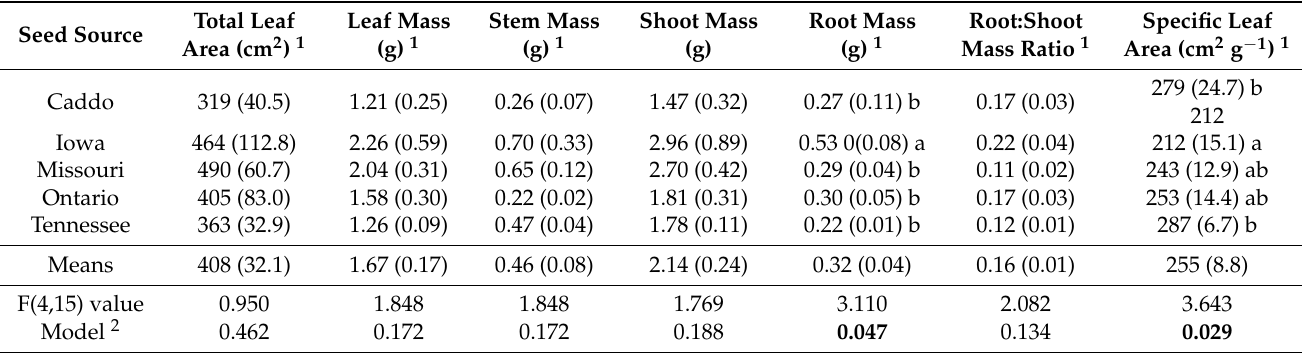
Table 2. Morphological characteristics of 10-week-old Acer saccharum subsp. saccharum and Acer saccharum subsp. nigrum (Iowa) seedlings by source prior to preconditioning through moist or dry cycles. ( n = 20).